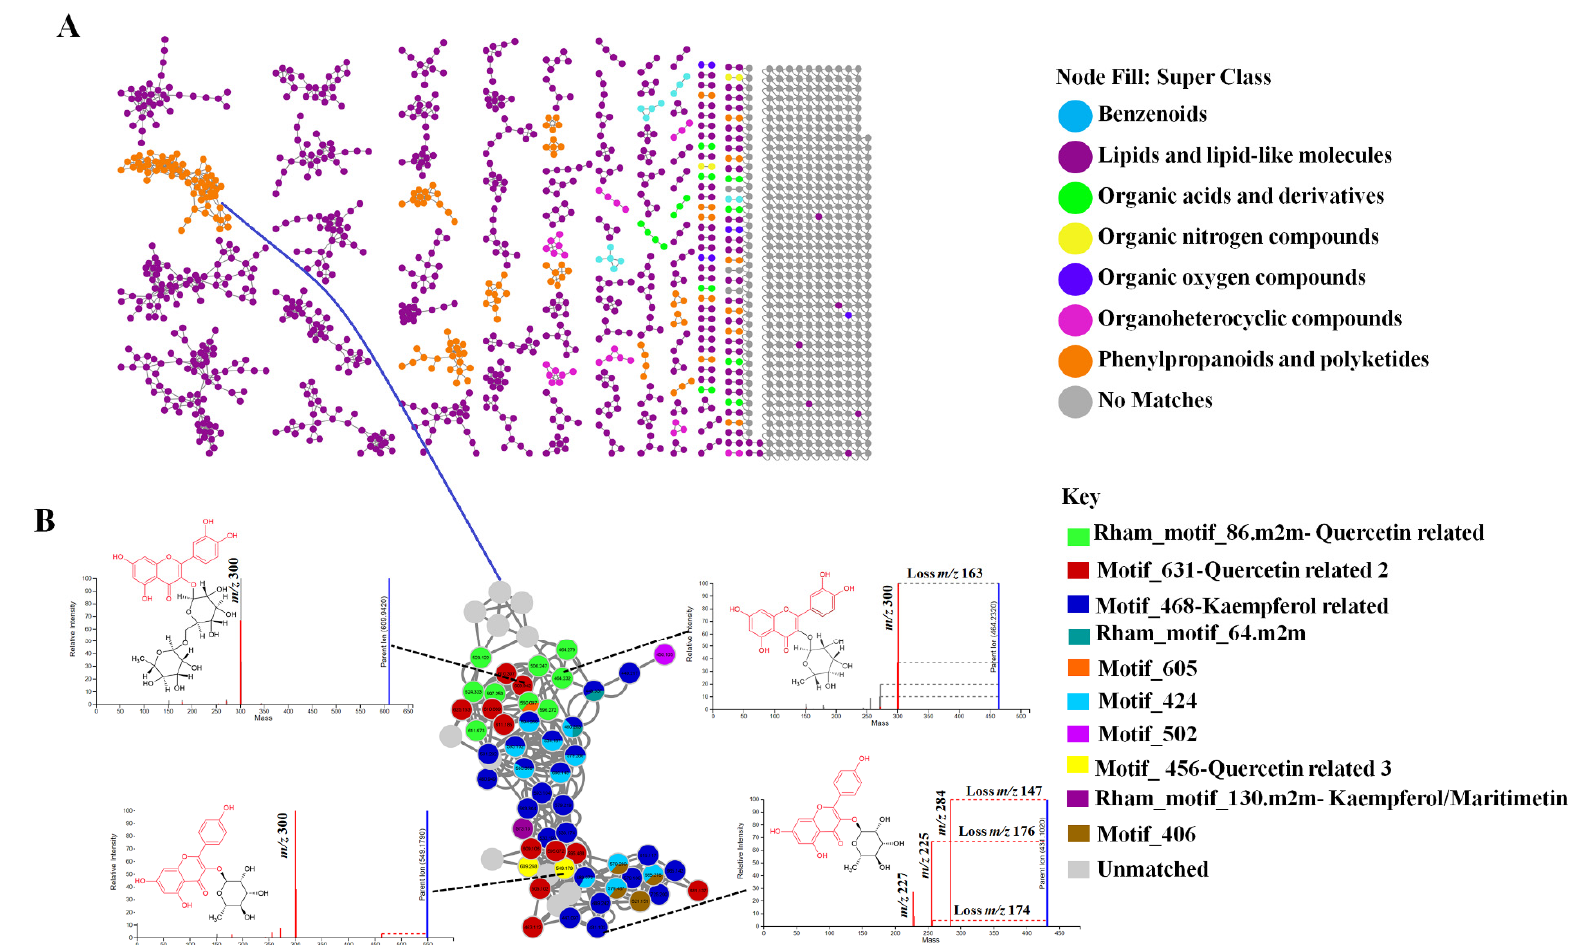
Figure 2. Chemical classification and structural elucidation. ( A ) An enhanced molecular network in which nodes are coloured based on their chemical superclass. The node annotations were based on substructure annotation (MS2LDA), network annotation propagation (NAP) and DEREPLICATOR output. ( B ) Metabolite annotation using NAP and by MS2LDA, the coloured parts of the structures indicate the parts that make up the Mass2Motifs.